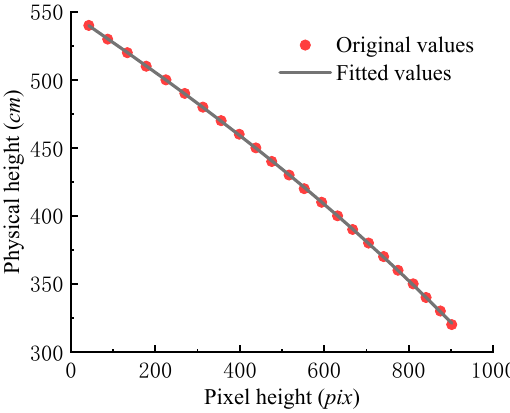
Figure 5. Scale calibration relationship.